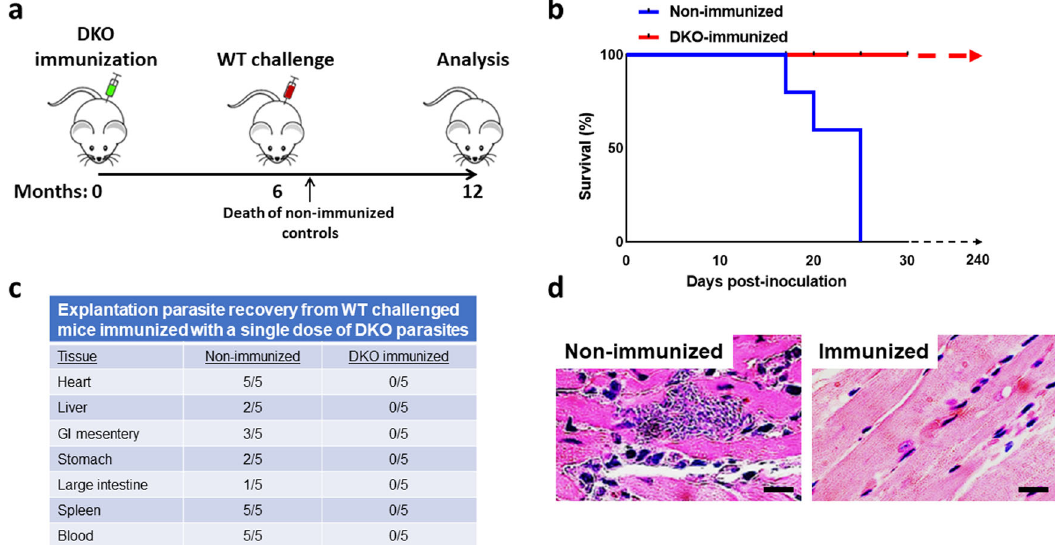
Fig. 9 Single dose DKO immunization of mice is protective against lethal challenge. a Timeline of immunization and WT challenge of mice. Mice were given a single DKO immunization with 10 5 parasites then challenged with WT parasites 24 weeks post-immunization ( n = 5). Non- immunized mice served as controls. Terminal analysis of DKO-immunized mice was conducted 24 weeks after WT challenge. b Survival curve of WT-challenged non-immunized control mice and DKO-immunized mice. All DKO-immunized mice survived WT challenge whereas all non- immunized mice died within 18 – 25 days post-challenge. Challenged DKO-immunized animals were observed for up to 240 days post challenge and no animals developed clinical disease. Treatment of these animals with dexamethasone (Dexa) does not induce clinical disease, alter survival or cause the emergence of parasites from tissues in any animal in the group (not shown). c Explantation of indicated tissues in parasite culture medium from WT-challenged non-immunized (at or near the time of death) or DKO-immunized mice 240 days post-infection. d Histopathologic analysis of heart sections of WT-challenge non-immunized (left panel) and DKO-immunized mice (right panel). This experiment contained 5 mice per group. The Log-rank (Mantel-Cox test) was used for the Kaplan – Meier analysis. P <